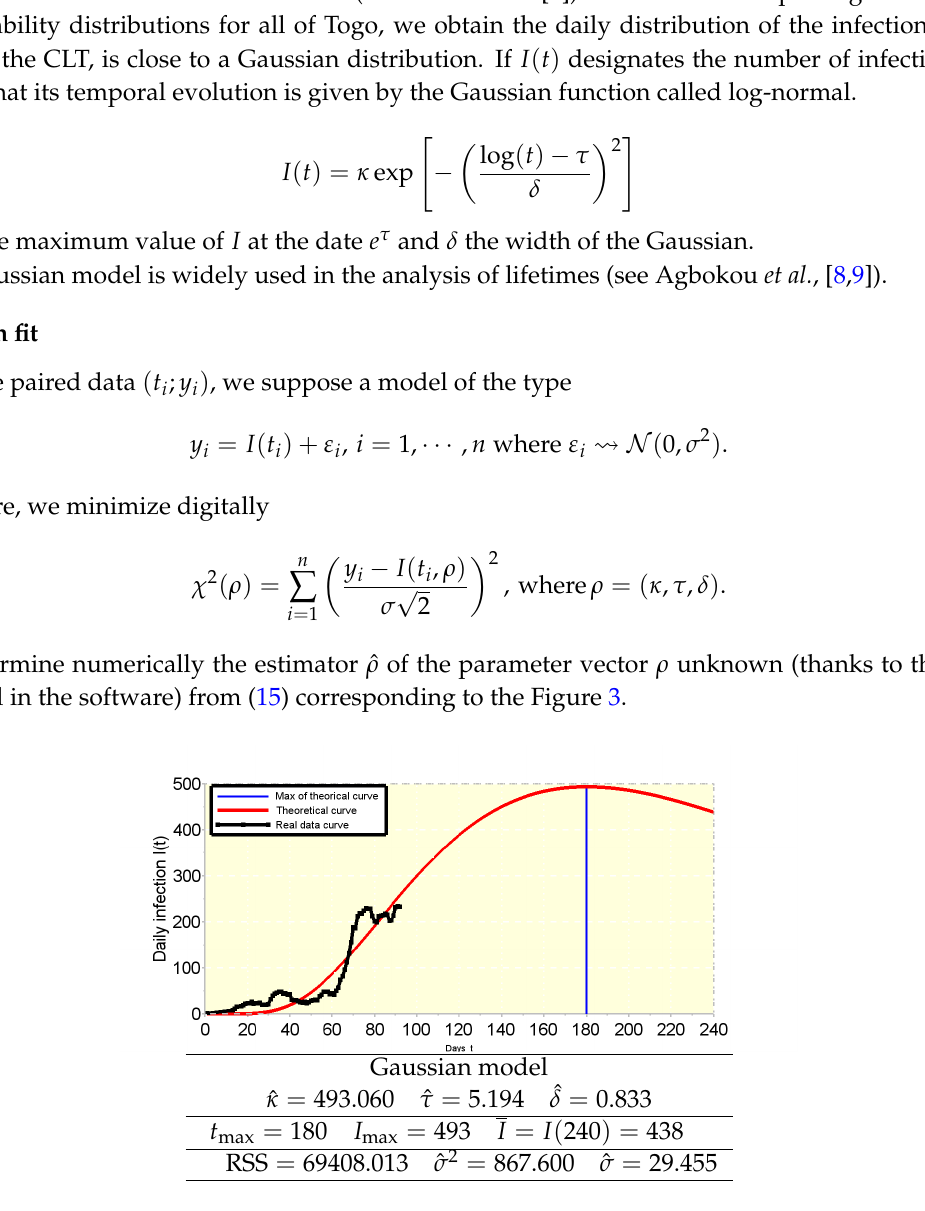
Figure 3. Gaussien